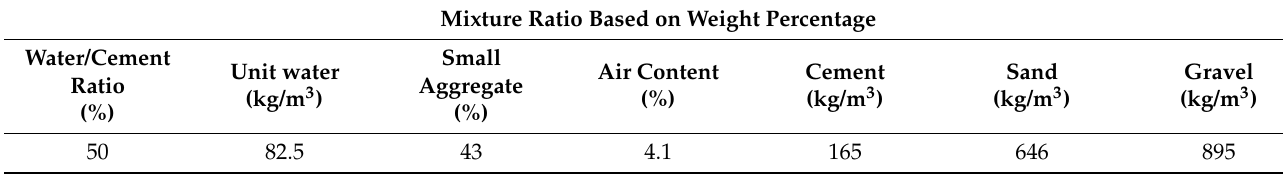
Table 5. Base (substrate as deck slab) concrete mixture condition. Mixture Ratio Based on Weight Percentage